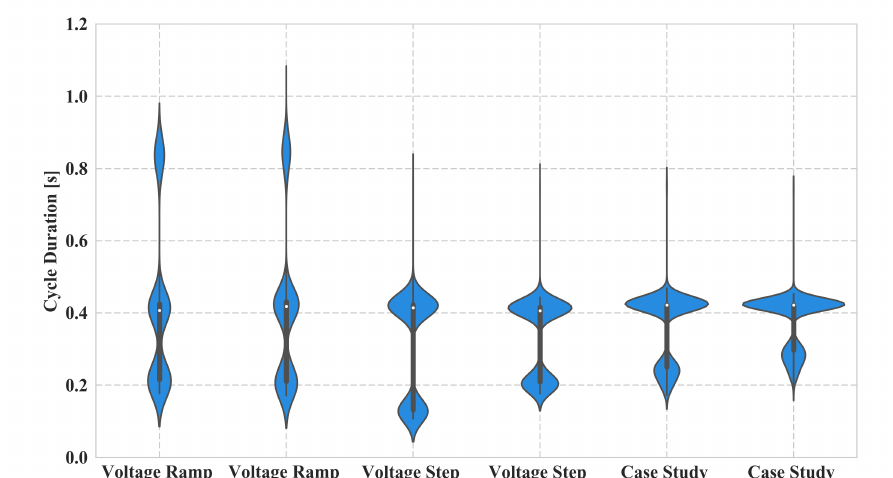
Figure 12. Illustration of the cycle time t PHIL for System Setup B for use in the evaluations of Phase 1 as well as for use in Phase 2. The white circle represents the median of the violin plot, the bold line represent the interquartile range and the blue areas represent the density